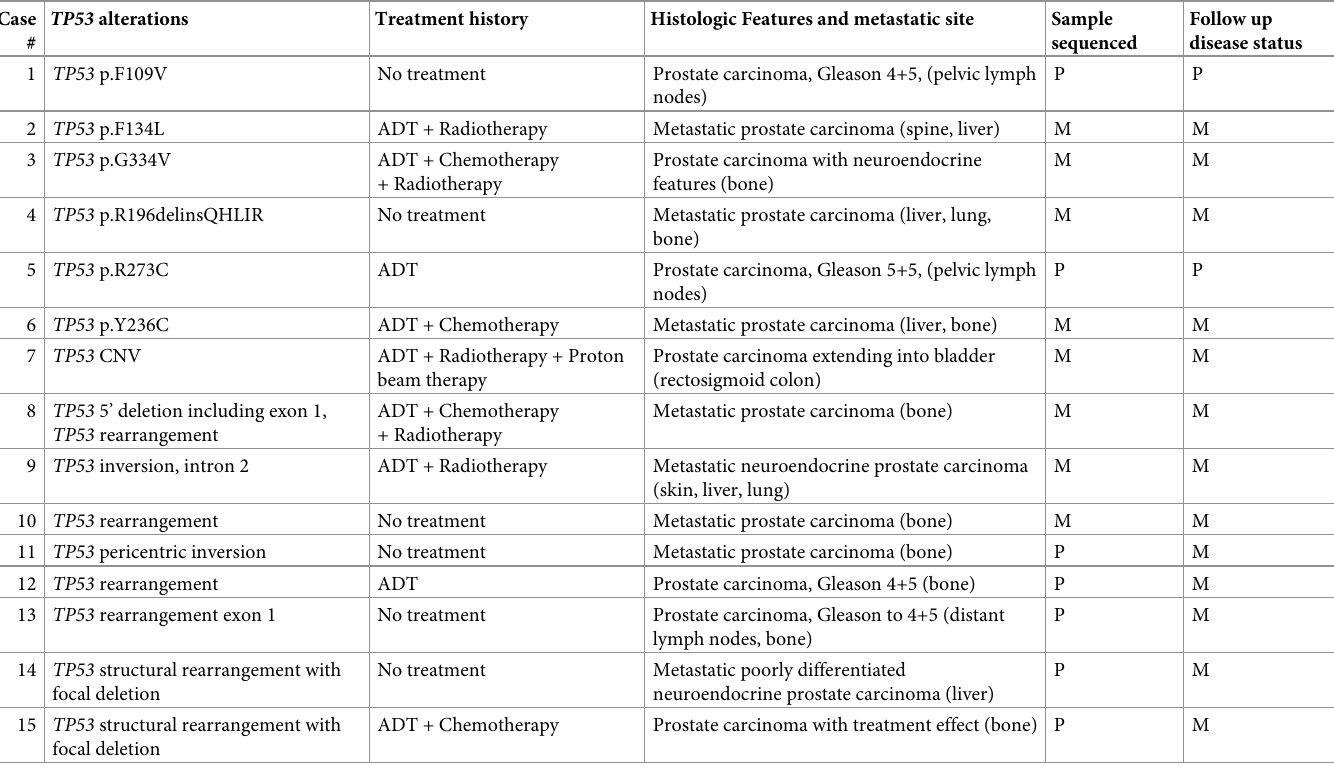
Table 2. TP53 alterations in a subset of prostate carcinomas identified by targeted next generation sequencing and selected clinical